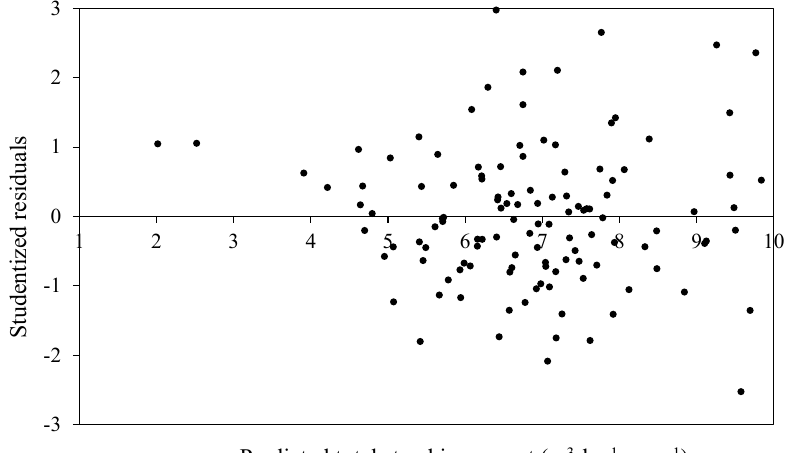
Figure 5. Residuals for the best model for total periodic annual increment in volume (PAIV tot )